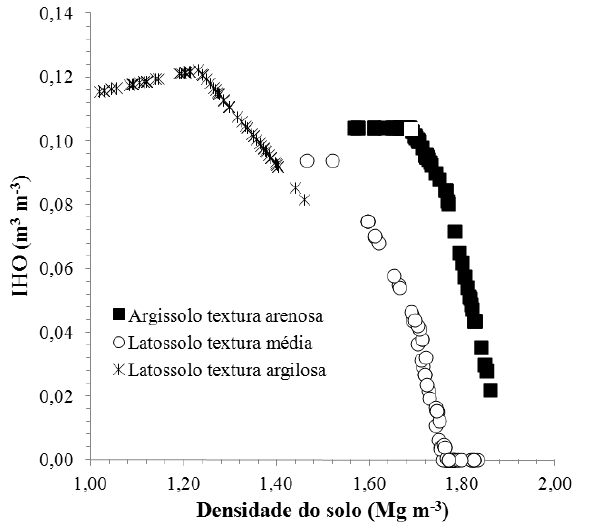
Figura 3. Intervalo hídrico ótimo (IHO) em função da densidade dos três solos